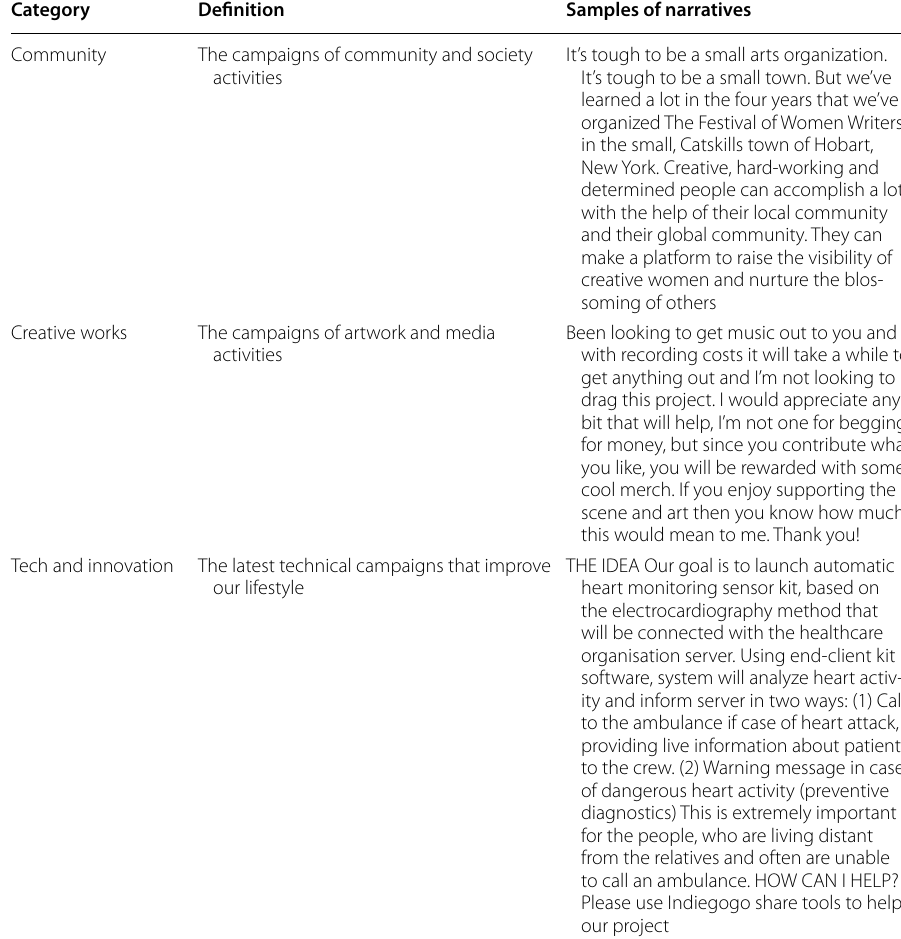
Table 2 Samples of narratives